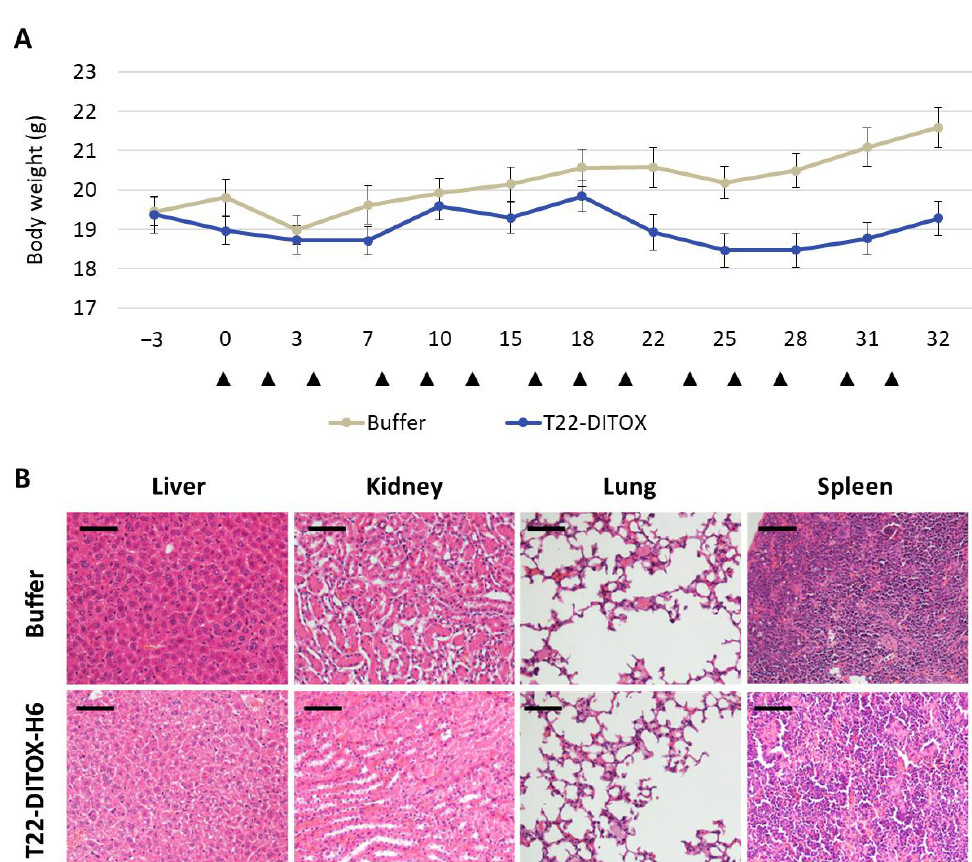
Figure 9. Lack of systemic toxicity after T22-DITOX-H6 repeated administration in the disseminated CXCR4 + AN3CA endometrial model. ( A ) Body weight evolution over time. Black arrows indicate treatment administration ( B ) Histological analysis of hematoxylin-eosin-stained sections of non-tumor organs (liver, kidney, lung and spleen) in mice treated with buffer or T22-DITOX-H6 (bar: 100 μm). Notice the lack of histopathological alterations in all studied tissues.